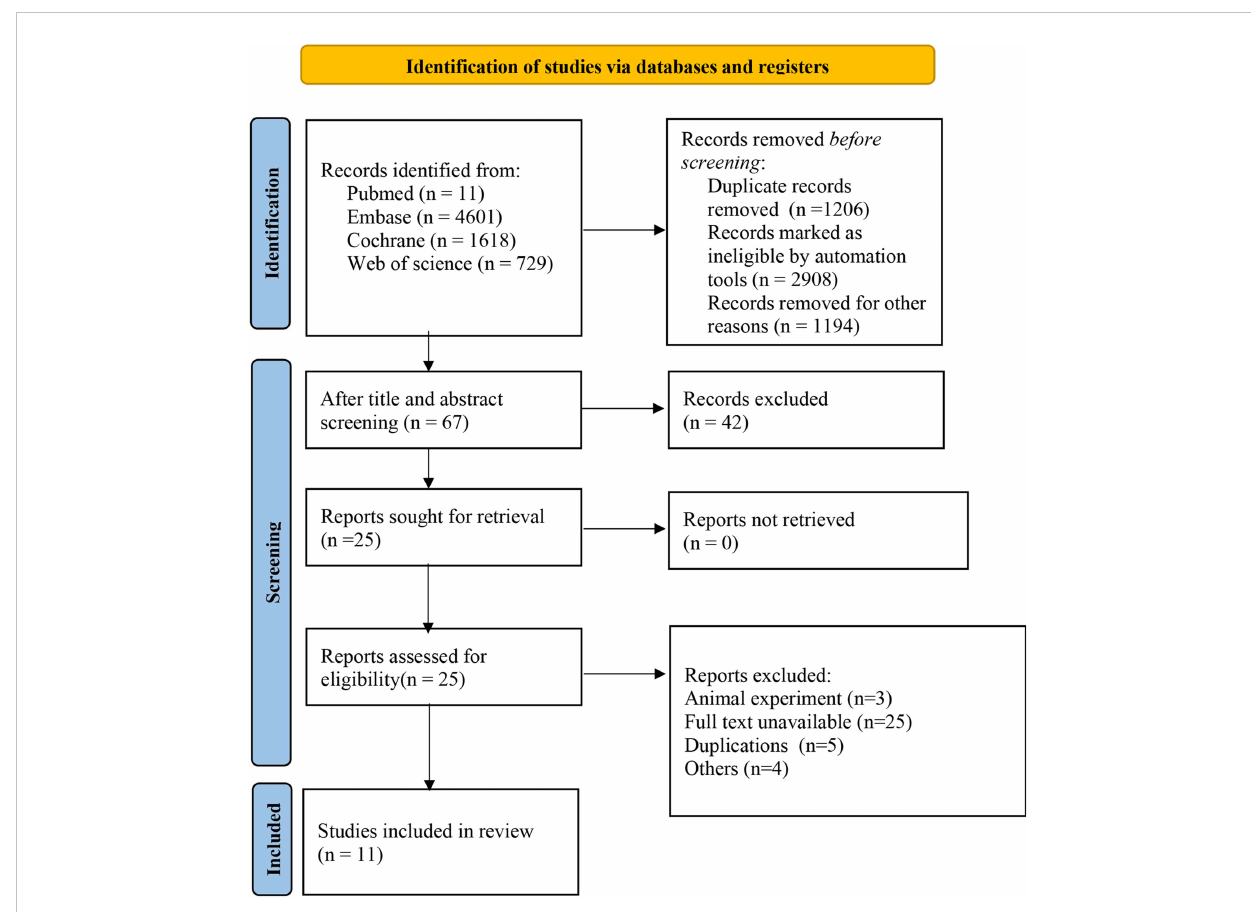
FIGURE 1 Literature screening fl owchart. Other reasons: inconsistent intervention, inconsistent population, animal experiments, meta-analyses,